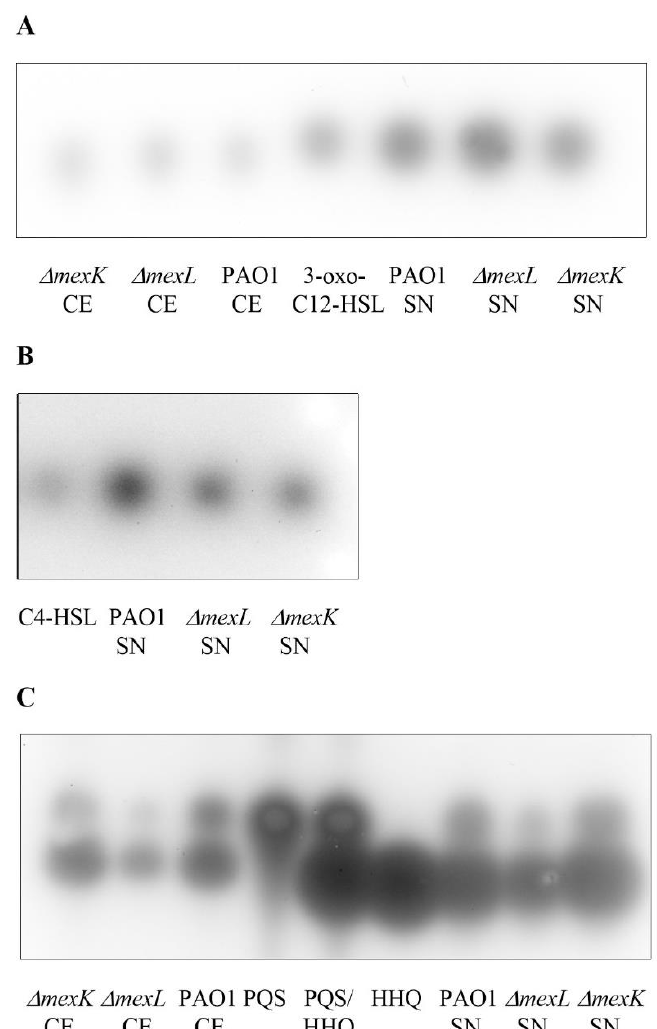
Figure 5. Accumulation of QSSMs both in supernatant and in cellular extracts of PAO1, ∆ mexL , and ∆ mexK strains grown in LB medium. Thin-layer chromatography analysis of both cell extracts (CEs) and supernatants (SNs) of PAO1, ∆ mexL , and ∆ mexK cultures grown to late exponential (AHLs; OD 600 = 1.7) or early stationary phase (AQs; OD 600 = 2.5) coupled to the growth of ( A ) LasR, ( B ) RhlR, or ( C ) PqsR-based biosensor strain. Since C4-HSL freely diffuses through the plasma membrane and